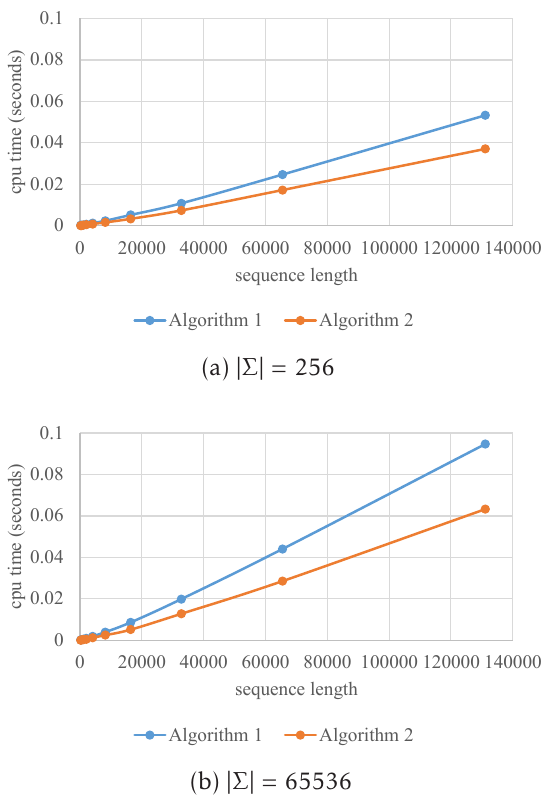
Figure 4. Average CPU time for sequences of 32-bit integers from varying size